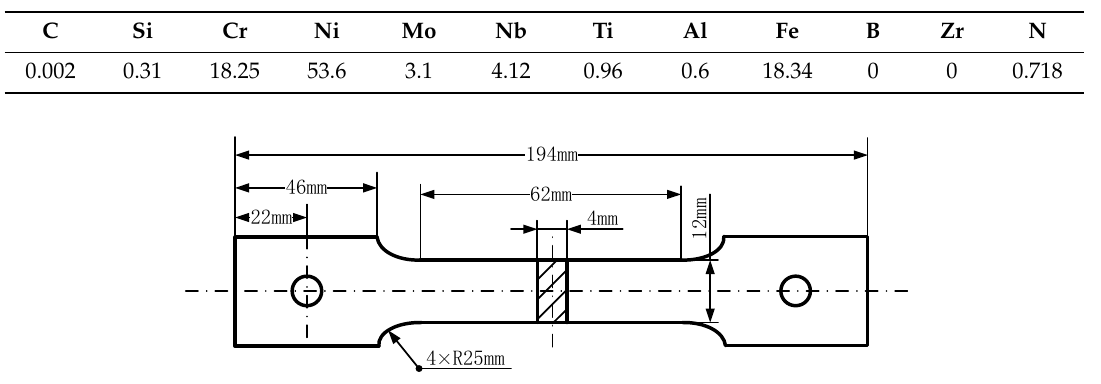
Figure 1. Schematic diagram of specimen size for tensile test (unit: mm).